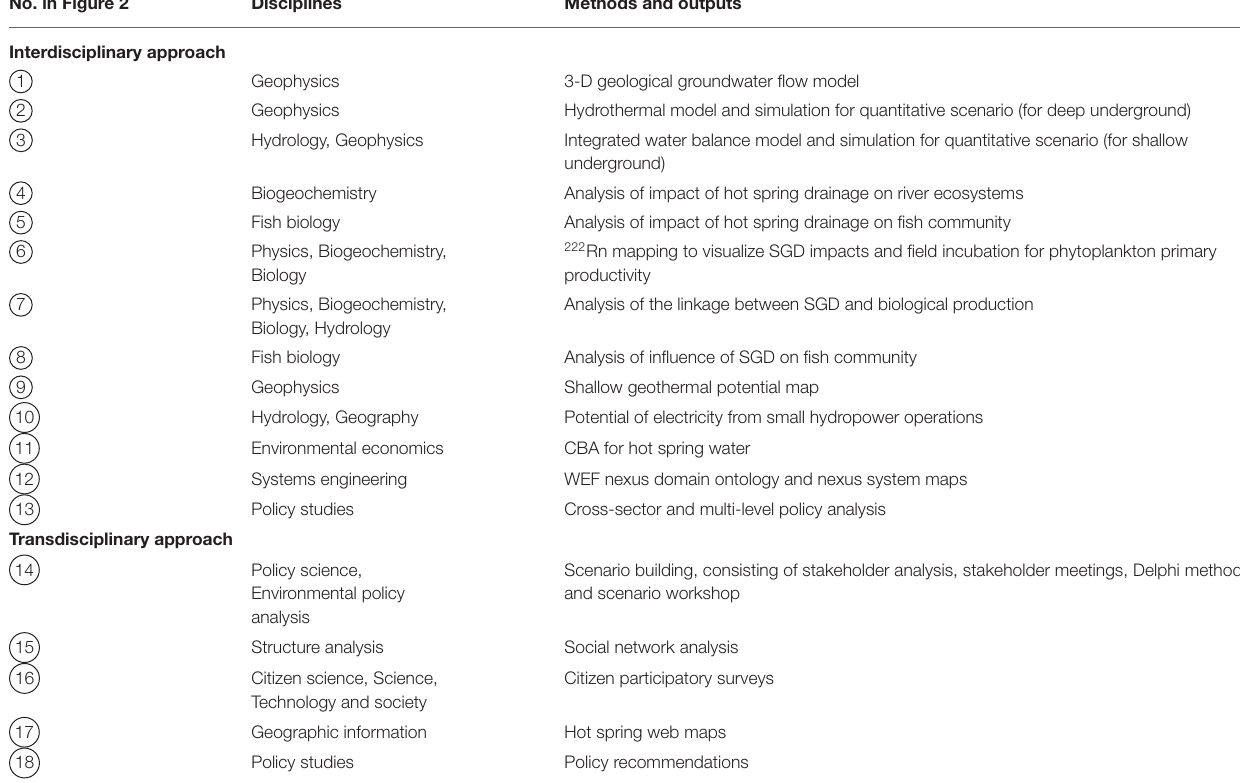
TABLE 1 | Methods applied and outputs in Beppu. No. in Figure